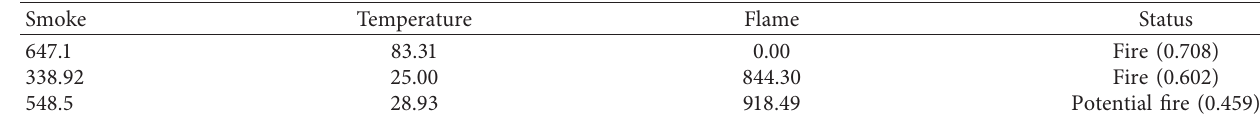
Table 8: Performance evaluation of fire